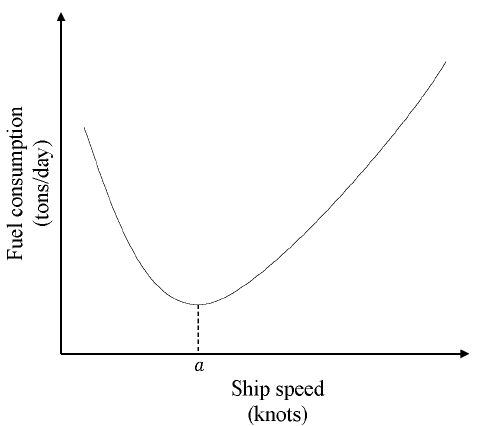
Figure 1. Qualitative graph of nonlinear relationship between carbon emission and